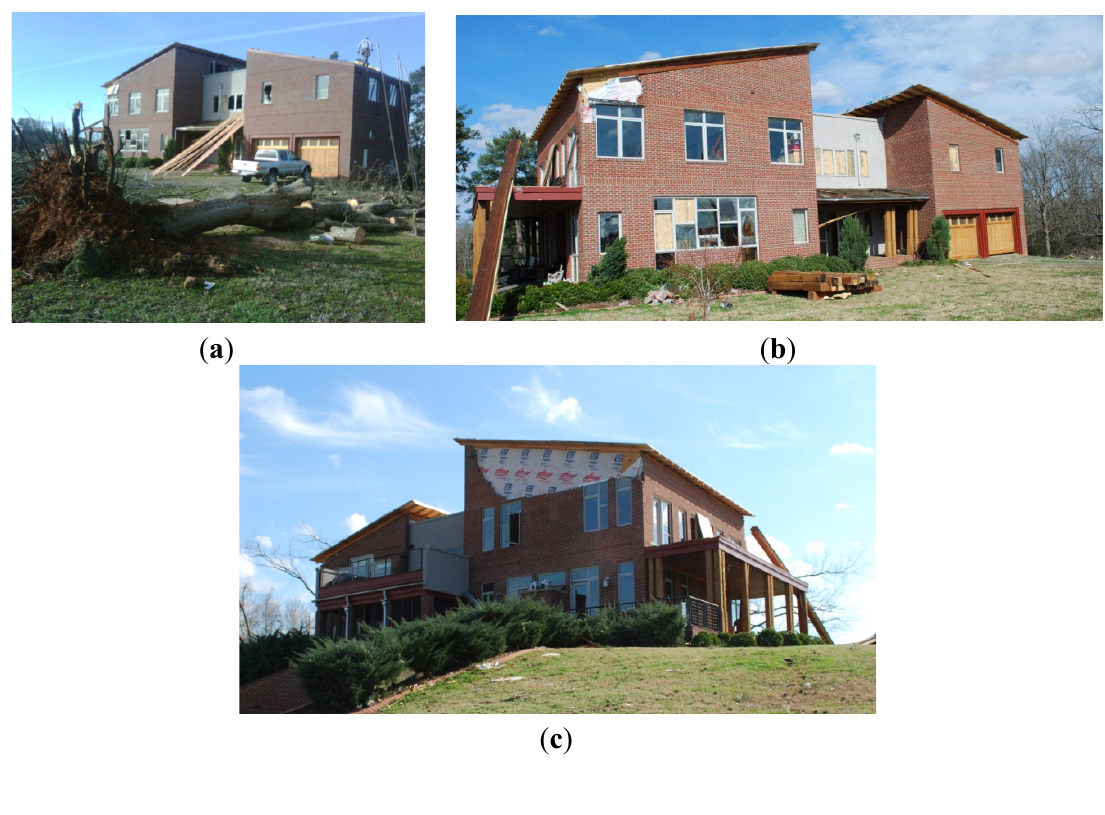
Figure 5. ( a ) Roof entirely removed; ( b ) Windows broken due to wind-borne debris; ( c ) Walls partially